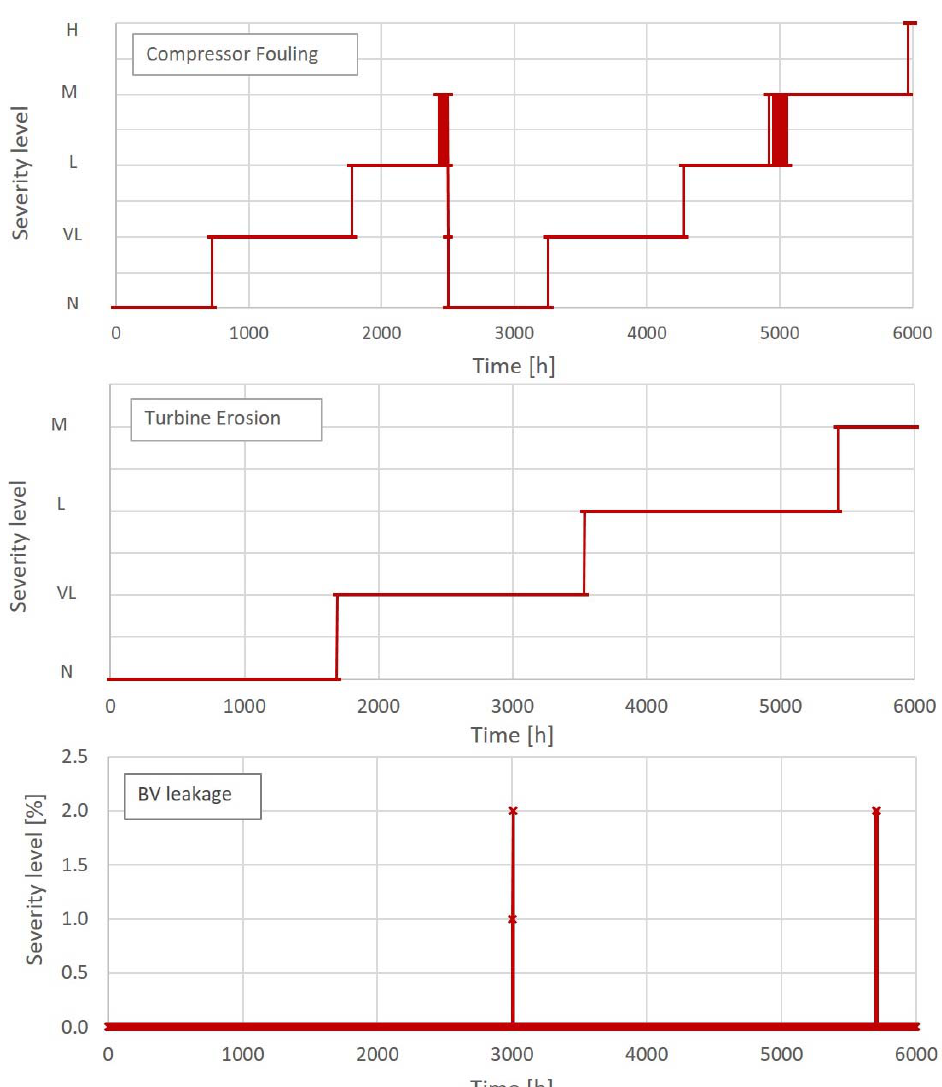
Figure 6. Estimated compressor and turbine flow capacity deviations from the performance model in Scenario 1.